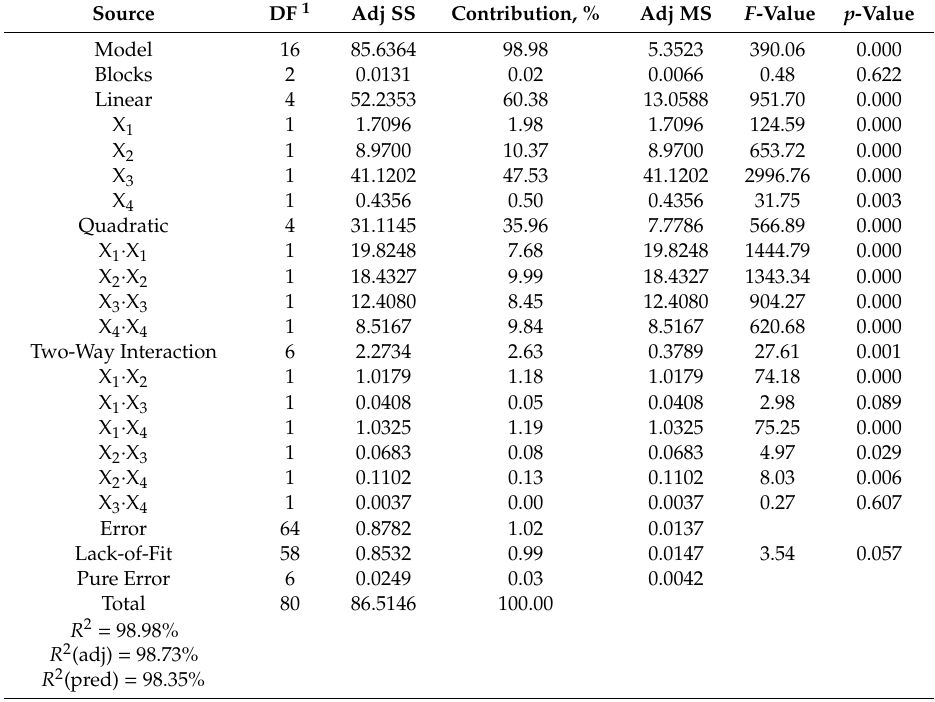
Table 3. Analysis of variance for the response surface model of the independent variables of micelle-mediated extraction of total phenolic compounds from apple